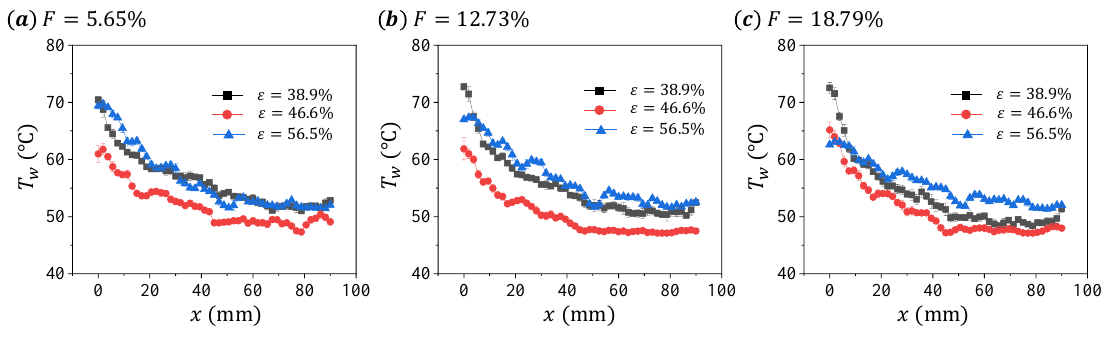
Figure 5. The distribution of surface temperature T w along the central line of the test sample for different porosity ε at same blowing ratio F : ( a ) F = 5.65%, ( b ) F = 12.73%, and ( c ) F = 18.79%.